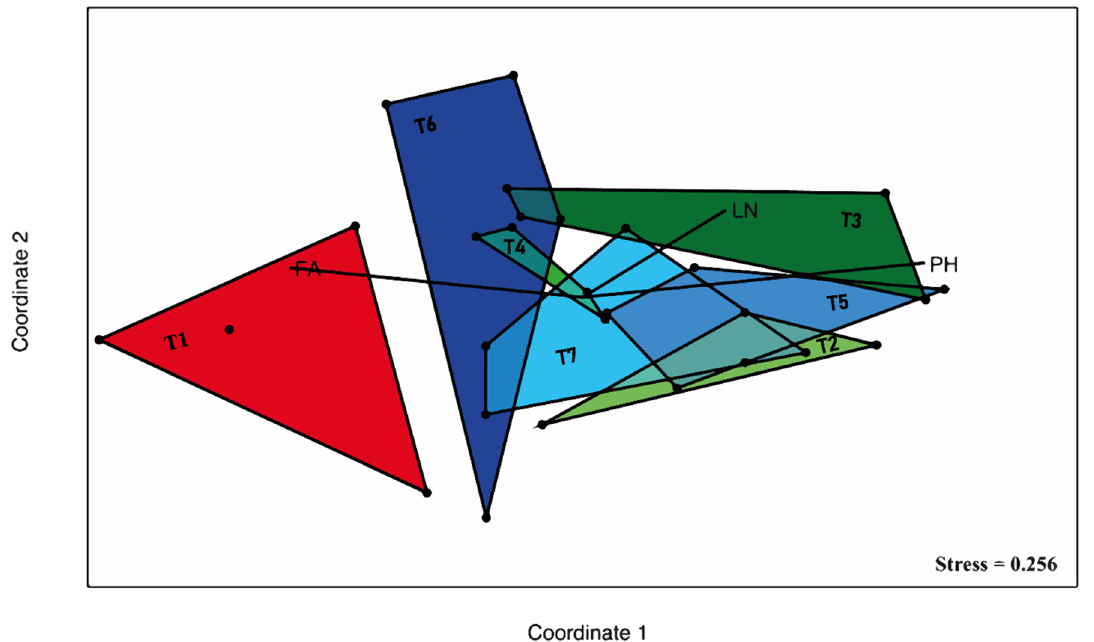
Figure 4. Nonmetric multidimensional scaling (NMDS) plot based on Bray–Curtis dissimilarities of fungal ITS region-based PCR-DGGE bands. Plant health parameters (plant height, number of leaves) and fungal abundance in qPCR were used here as vectors for NMDS analyses. T1 to T7 treatments: T1 = F; T2 = 19 + F; T3 = 76 + F; T4 = 19 + 76 + F; T5 = F + 19; T6 = F + 76; T7 = F + 19 + 76. PH = plant height, LN = number of leaves and FA = fungal abundance.